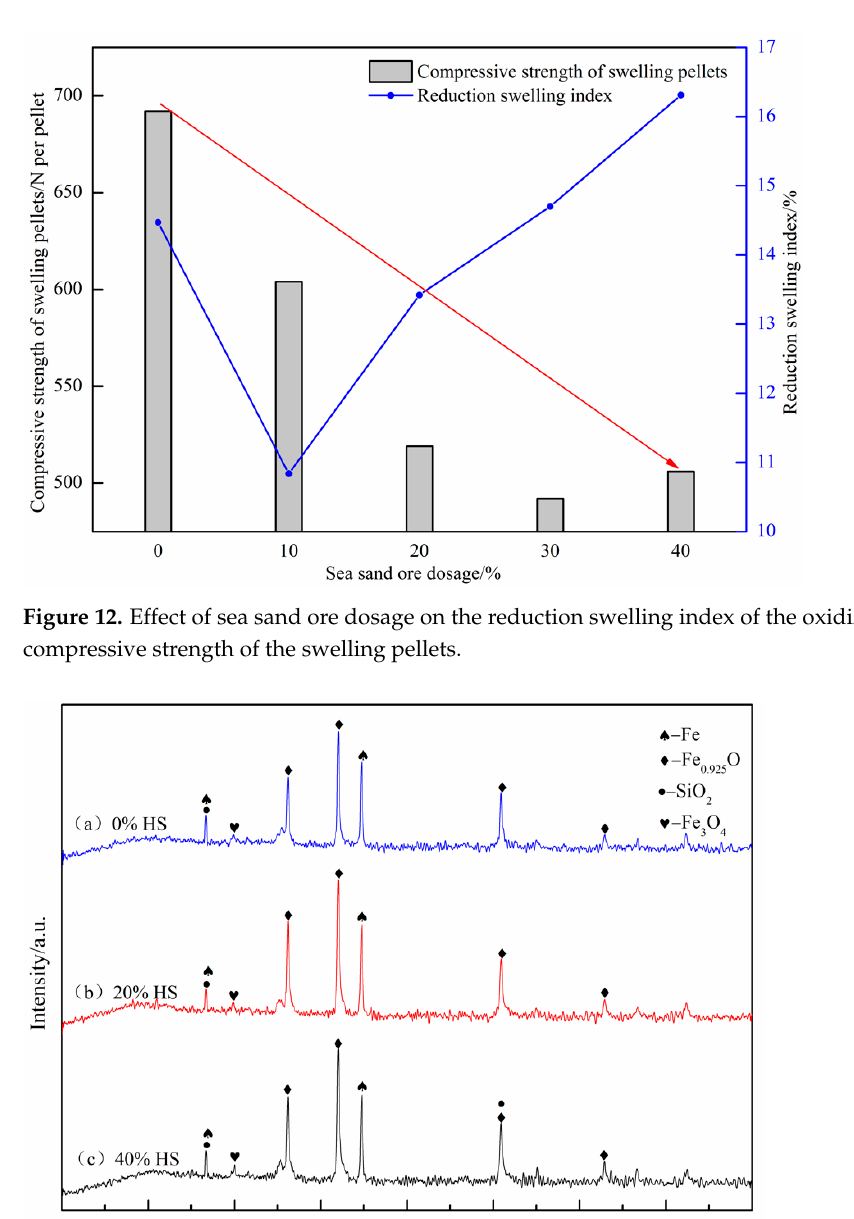
Figure 12. Effect of sea sand ore dosage on the reduction swelling index of the oxidized pellets and compressive strength of the swelling pellets.